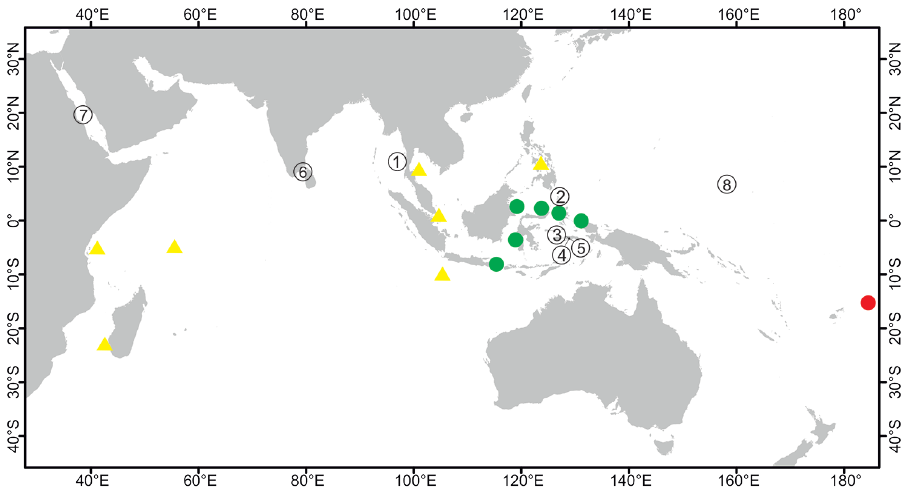
Figure 2. Distribution of Paratetilla bacca . Red dot: type locality, Stelletta bacca Selenka, 1867, American Samoa. Green dots: Indonesian localities where the species was collected recently. Yellow triangles: Re- cords from localities outside Indonesia, Zanzibar, Southwest Madagascar, Seychelles, Thailand, Singapore, Christmas Island, and Philippines. Circled numbers: type localities of synonymized species, 1 Tethya mer- guiensis Carter, 1873, Mergui Archipelago 2 Tetilla ternatensis Kieschnick, 1896, Ternate Island 3 Tetilla amboinensis Kieschnick, 1898, Ambon Island 4 Tetilla violacea Kieschnick, 1898, Ambon Island 5 Tetilla rubra Kieschnick, 1898, Ambon Island 6 Paratetilla cineriformis Dendy, 1905, Gulf of Manaar, Sri Lanka. 7 Paratetilla eccentrica Row, 1911, Tella Tella Kabira, Red Sea 8 Paratetilla lipotriaena de Laubenfels, 1954, Matalanim, Eastern Pohnpei,